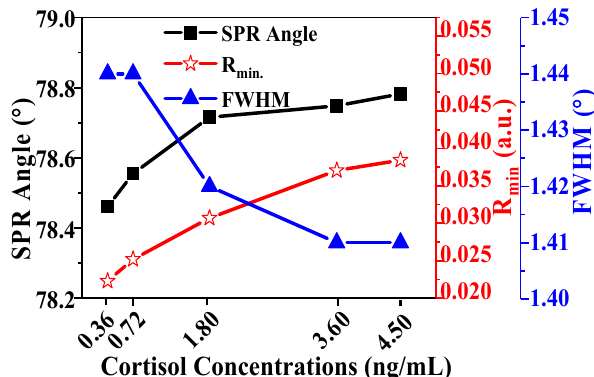
Figure 3. SPR curves for different cortisol concentrations in saliva. The inset shows the enlarged view between the incident angle 78 and 79.5° .